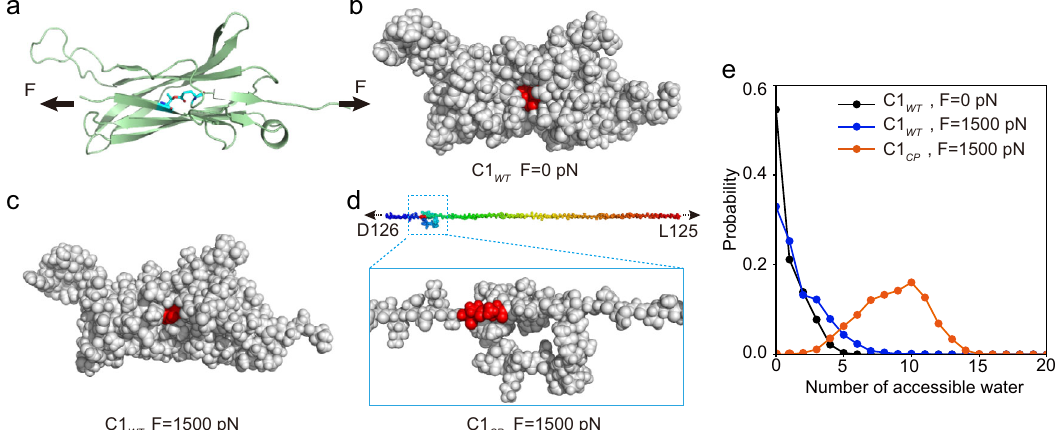
Fig. 4 Molecular dynamics simulations demonstrating different water accessibility of the ester bond in C1 WT and C1 CP under pulling force. a Cartoon representation of the three-dimensional structure of C1 WT under the pulling force of 1500 pN. The residues Thr-11 and Gln-141 forming the ester bond were also shown by sticks representation. Three-dimensional structure of C1 WT shown by sphere representation without force ( b ) and under the pulling force of 1500 pN ( c ). d Three-dimensional structure of C1 CP under the pulling force of 1500 pN shown by sphere representation. For clarity, the zoom-in structure was also shown. The residues Thr-11 and Gln-141 were colored in red in b – d . e Distribution of the number of water molecules within 5 Å from the O ε 1 atom of the Gln-141 for C1 WT (blue) and C1 CP (orange) at the constant pulling force of 1500 pN. For comparison, the result for C1 WT (black) without applying force was also shown. Source data are provided as a Source Data fi